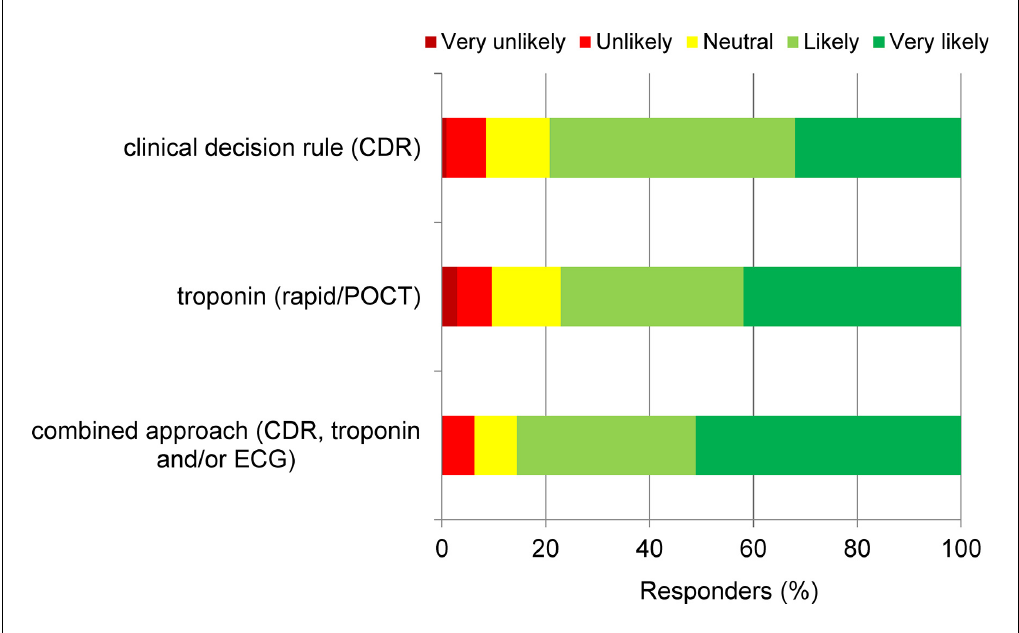
Figure 4. Attitude towards implementing clinical decision aids and POCTs. ECG = electrocardiogram. POCT = point of care test.